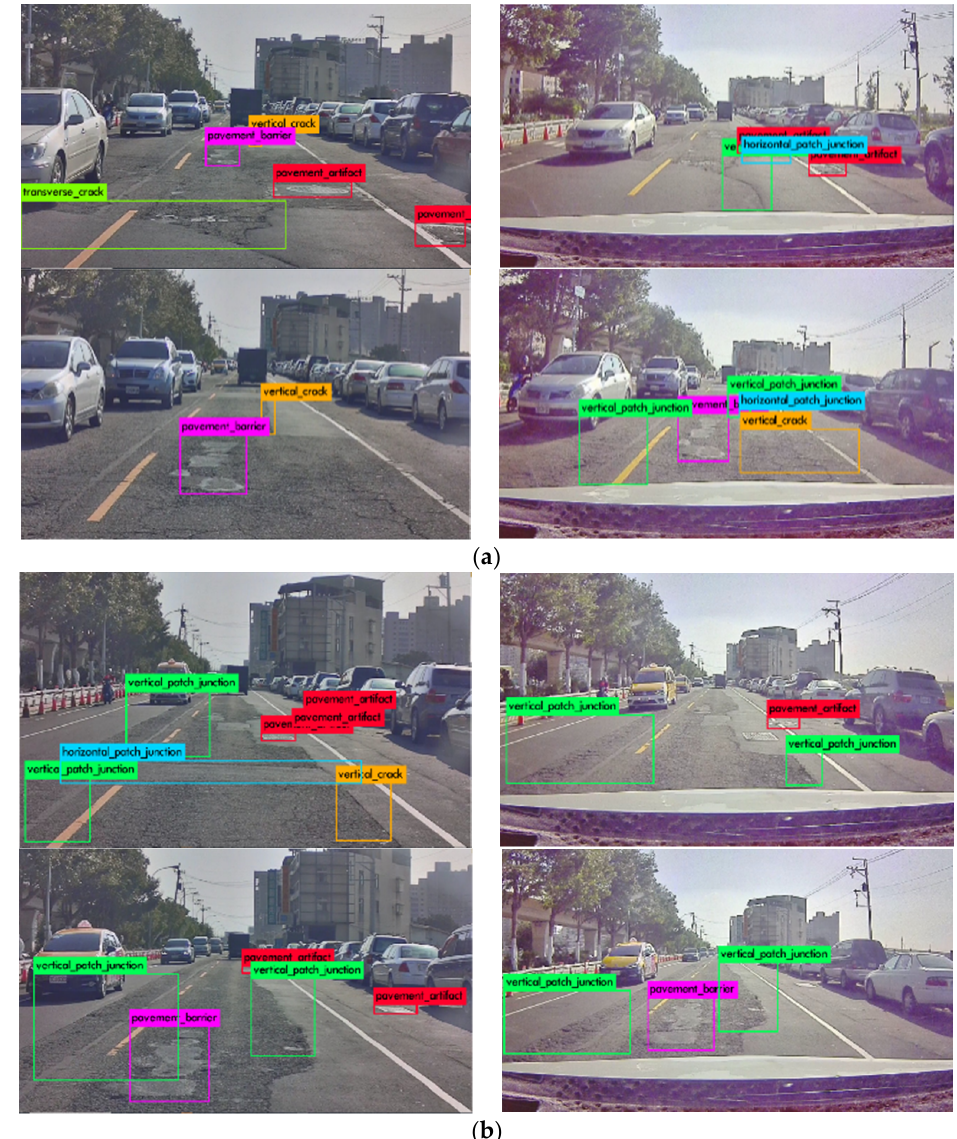
Figure 7. Pavement defect detection results by two lenses with different viewing angles. ( a ) Detection results at time step t; ( b ) Detection and tracking results at time step t + j